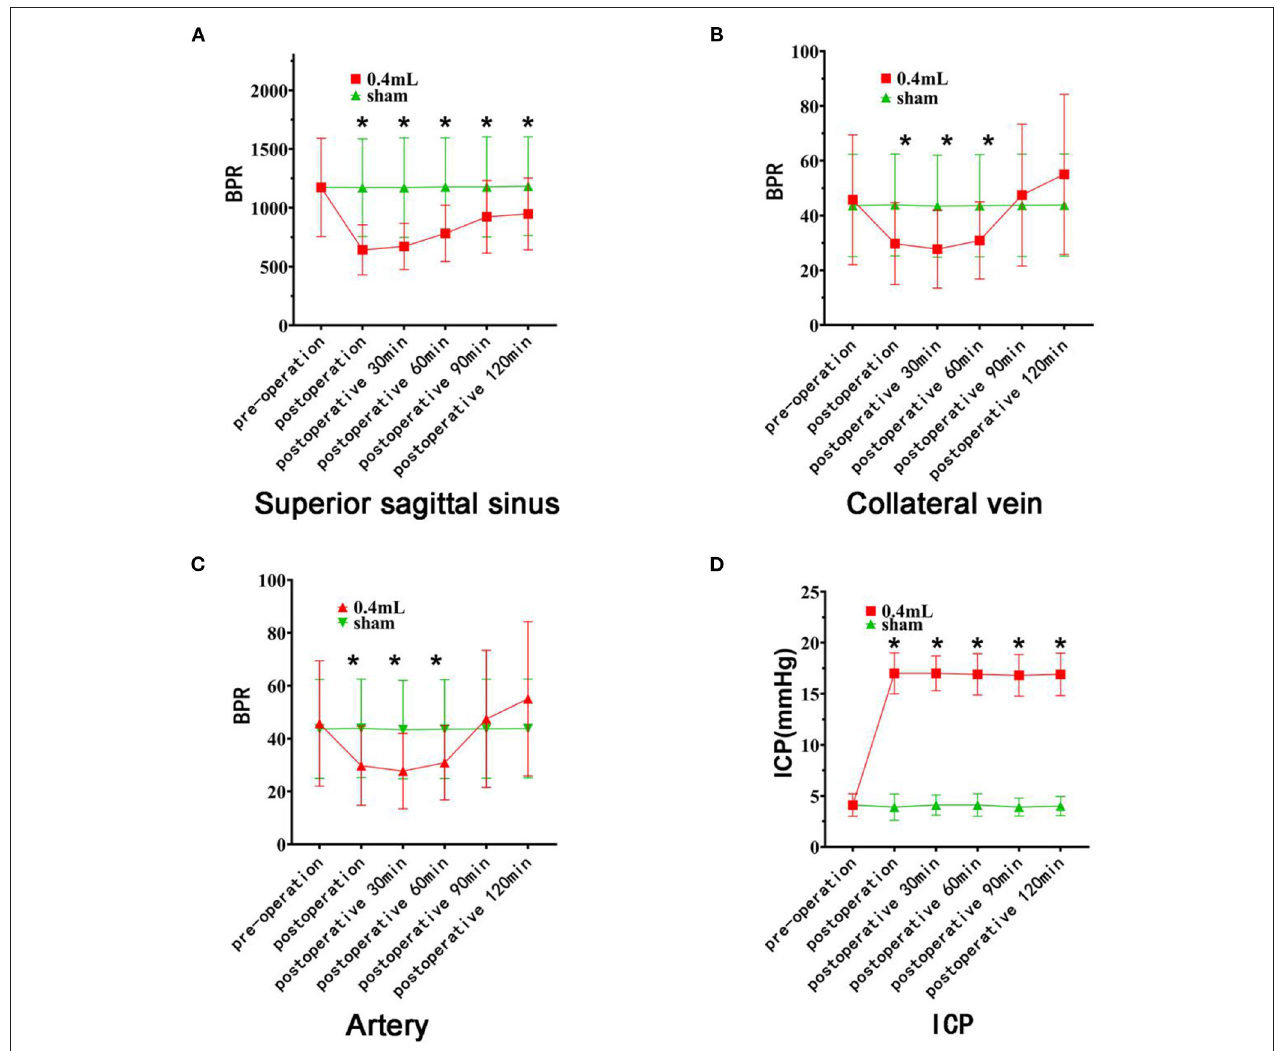
FIGURE 4 | Changes in blood flow and intracranial pressure on the cerebral surface of rats. The red curve represents the 0.4ml group, and the green curve represents the Sham group. (A) There was no difference in the BPR (mean ± standard deviation) of the superior sagittal sinus between the two groups before the operation. The BPR of the experimental groups decreased significantly after hematoma injection (asterisk). (B) There was no difference in BPR between the two groups before surgery. After hematoma injection, the BPR of the experimental group decreased significantly (asterisk) and recovered 90min after surgery. (C) There was no difference in preoperative BPR between the two groups of rats. After hematoma injection, the BPR of the experimental group decreased significantly (asterisk) and recovered by 90min after surgery. (D) There was no difference in intracranial pressure between the two groups before surgery, but there was a significant difference at each time point after surgery